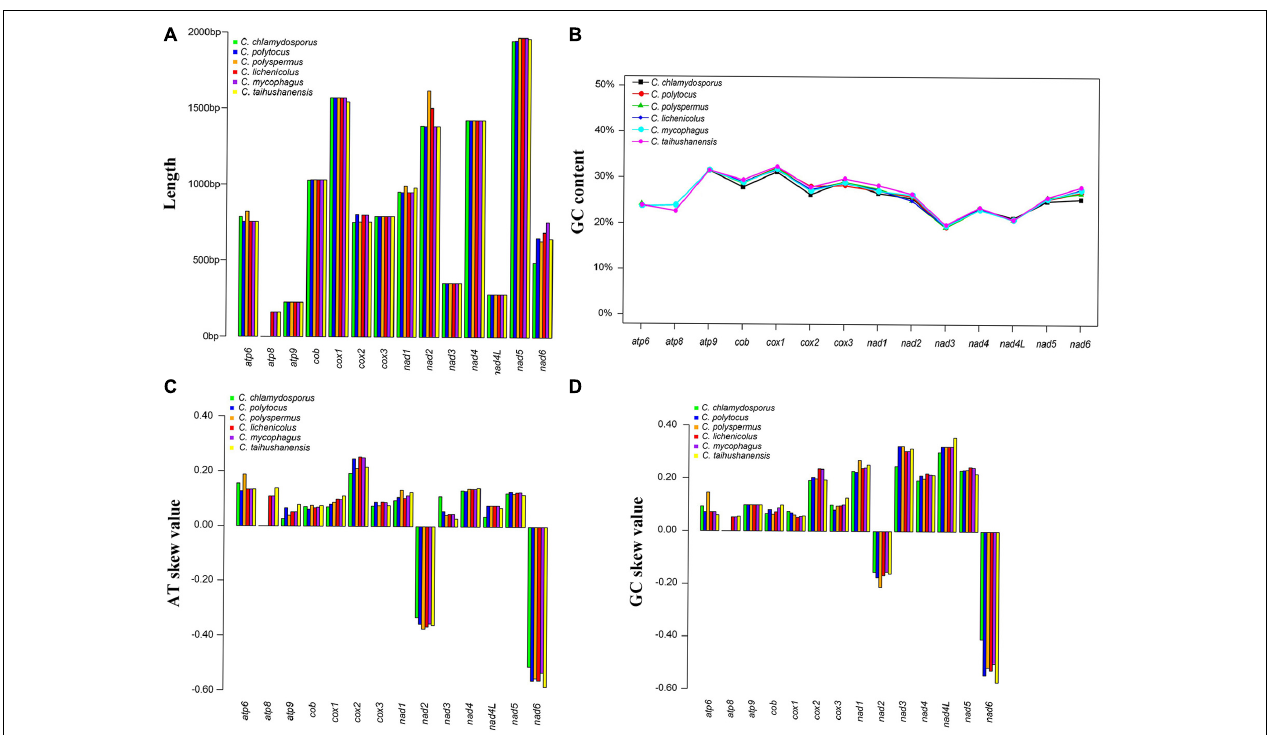
FIGURE 2 | Variations of 14 protein-coding genes (PCGs) in the six Conidiobolus s.s. mitogenomes. (A) Length; (B) GC content; (C) AT skews; (D) GC skews.